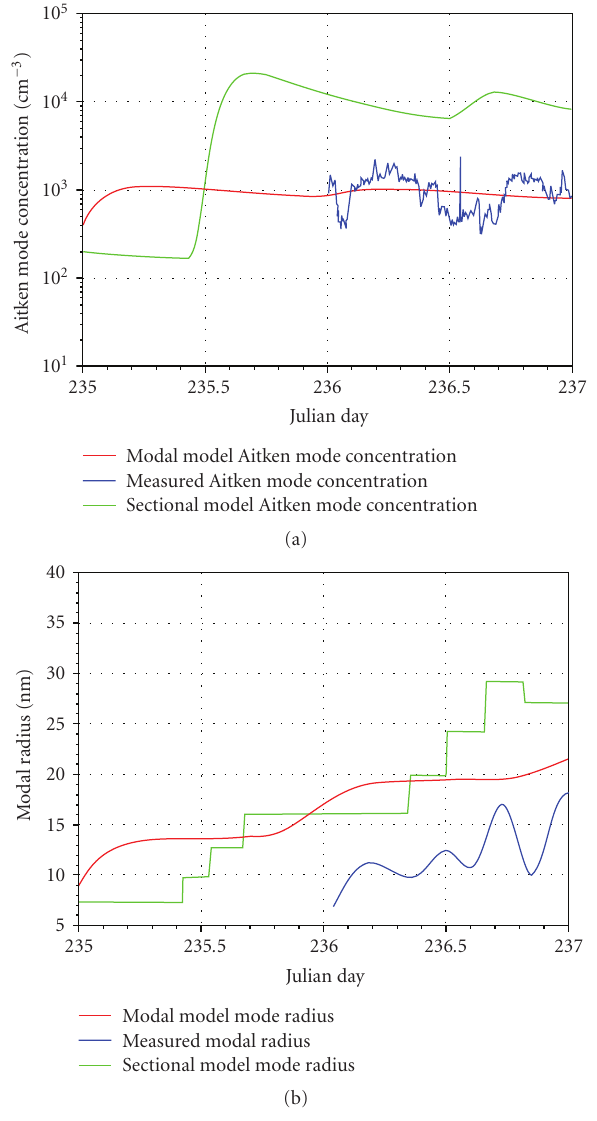
Figure 6: (a) Comparison of mode concentration and (b) mode radius between modeled and measured